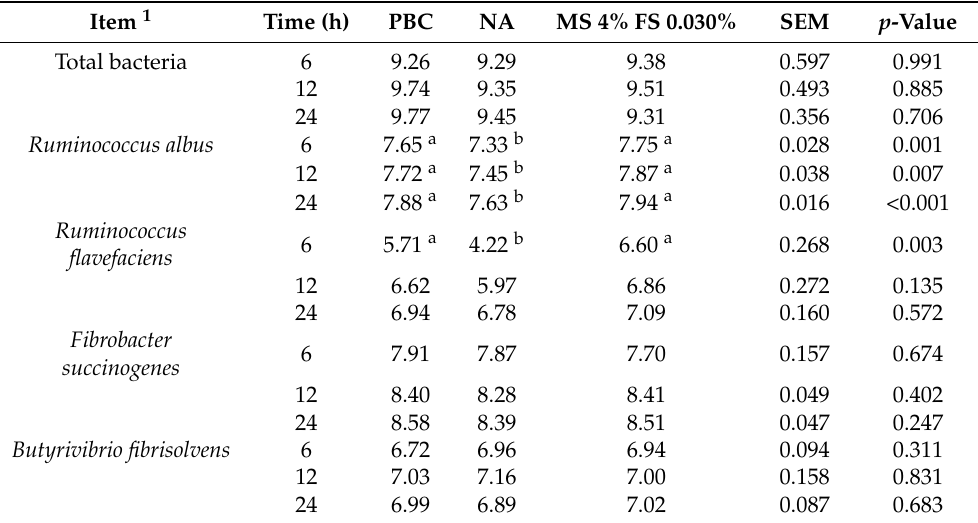
Table 6. Microbial composition (log 10 16S rRNA gene copies/mL) of both pre-ensiled materials and ensiled forms at three time points (6, 12, 24 h) during the in vitro rumen